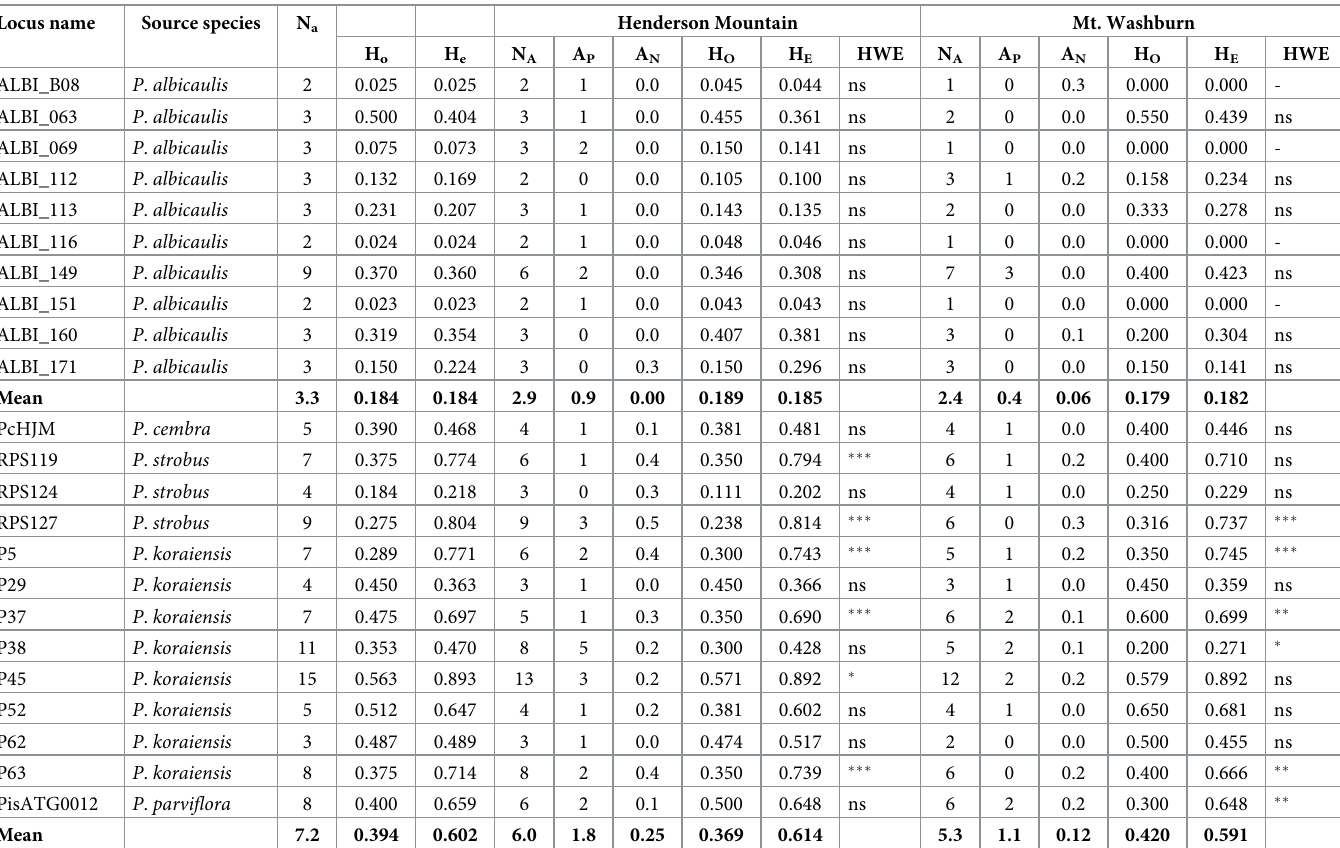
Table 2. Microsatellite loci, source species, and application to two populations of Pinus albicaulis in the Greater Yellowstone Ecosystem.